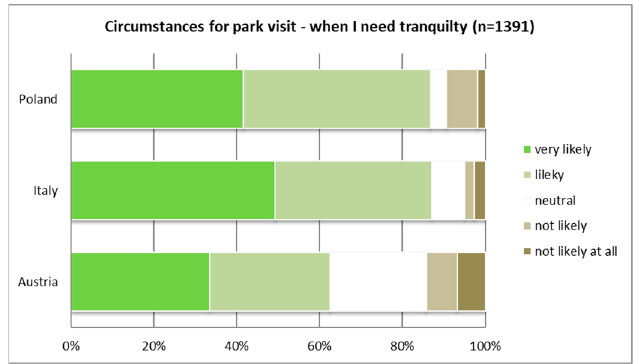
Figure 3. Visiting PAs to seek tranquility; cross-country comparison ( p ≤ 0.01).